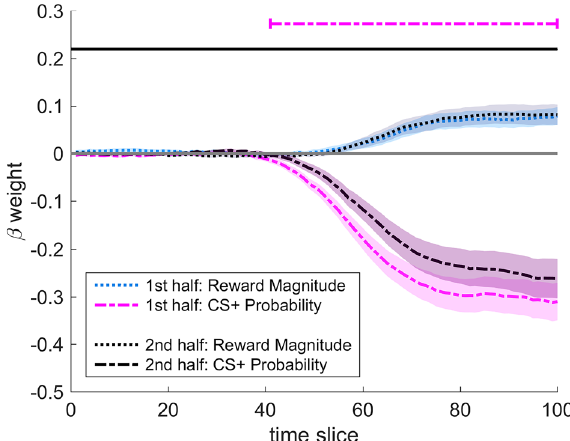
Figure 5. Time-continuous beta weights from TCMR analysis for the predictors Reward Magnitude and CS+ Probability for the first half (light-colored) and the second half (dark-colored) of the approach-avoidance paradigm in the aversive learning group. Positive β weights indicate movement tendencies towards the CS+/ high reward option, negative β weights indicate tendencies towards the CS−/low reward option. Horizontal lines at the top indicate segments of significant difference between both halves for a specific predictor. Shaded areas represent standard error of the mean. Only segments of more than 10 successive significant t -tests were accepted as meaningful. In the aversive learning group, a time slice corresponds on average to 7.8 ms.